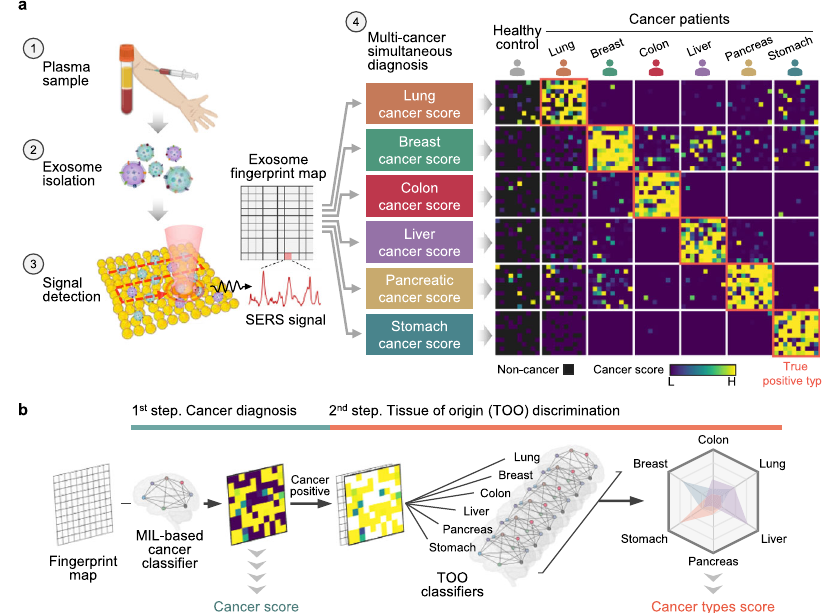
Fig. 1 | One test-multi cancer using exosome-SERS-AI. a Overview. Exosome suspension is dropped onto an Au nanoparticle-aggregated array chip and thor- oughlydried.Signalswereobservedat100spots(10×10)persampleandanalyzed byAIalgorithms.Thesystemoutputspredictionsaboutcancerpresenceandtissue oforigin.Aheatmapshowsactualexamplesoftherepresentativepredictedresults